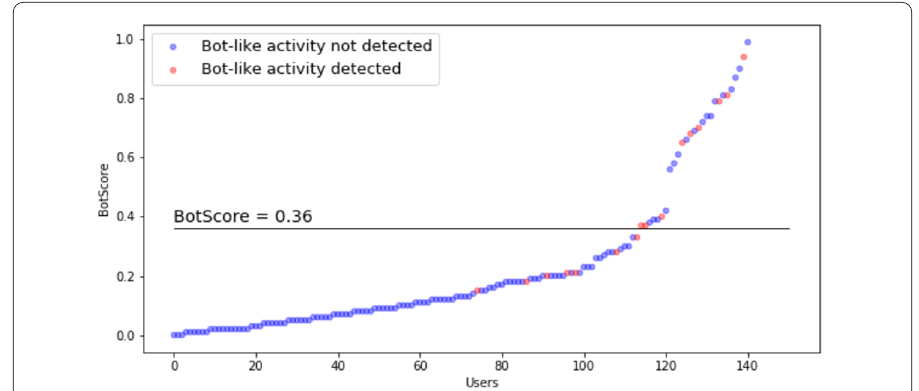
Figure 9 The Botometer vs human annotator evaluation of a small sample of accounts. More than half of the accounts that have been flagged as possible bots by human annotators (red dots) have a BotScore > 0.36. All the accounts that show patterns of automation have a BotScore >